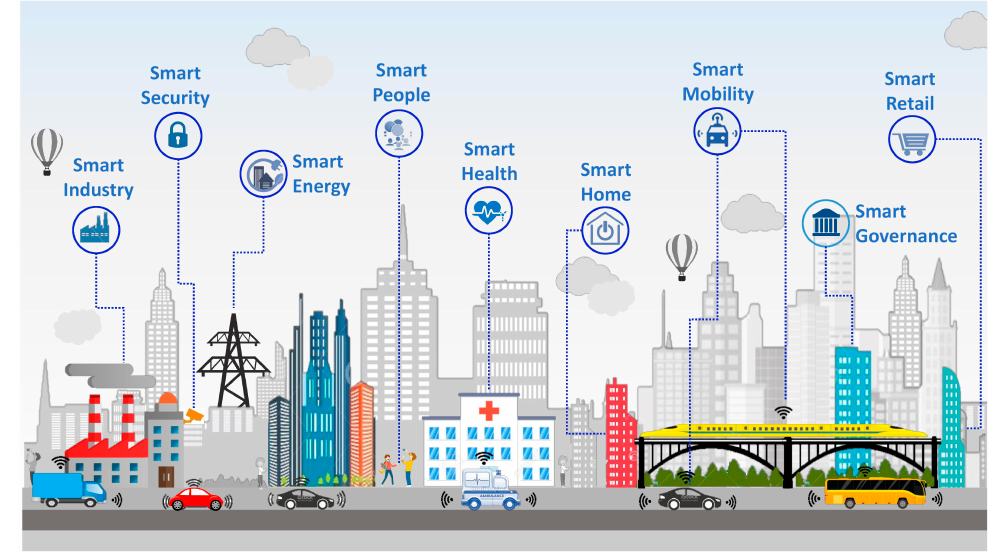
Figure 1. Overview of a generic smart city environment.